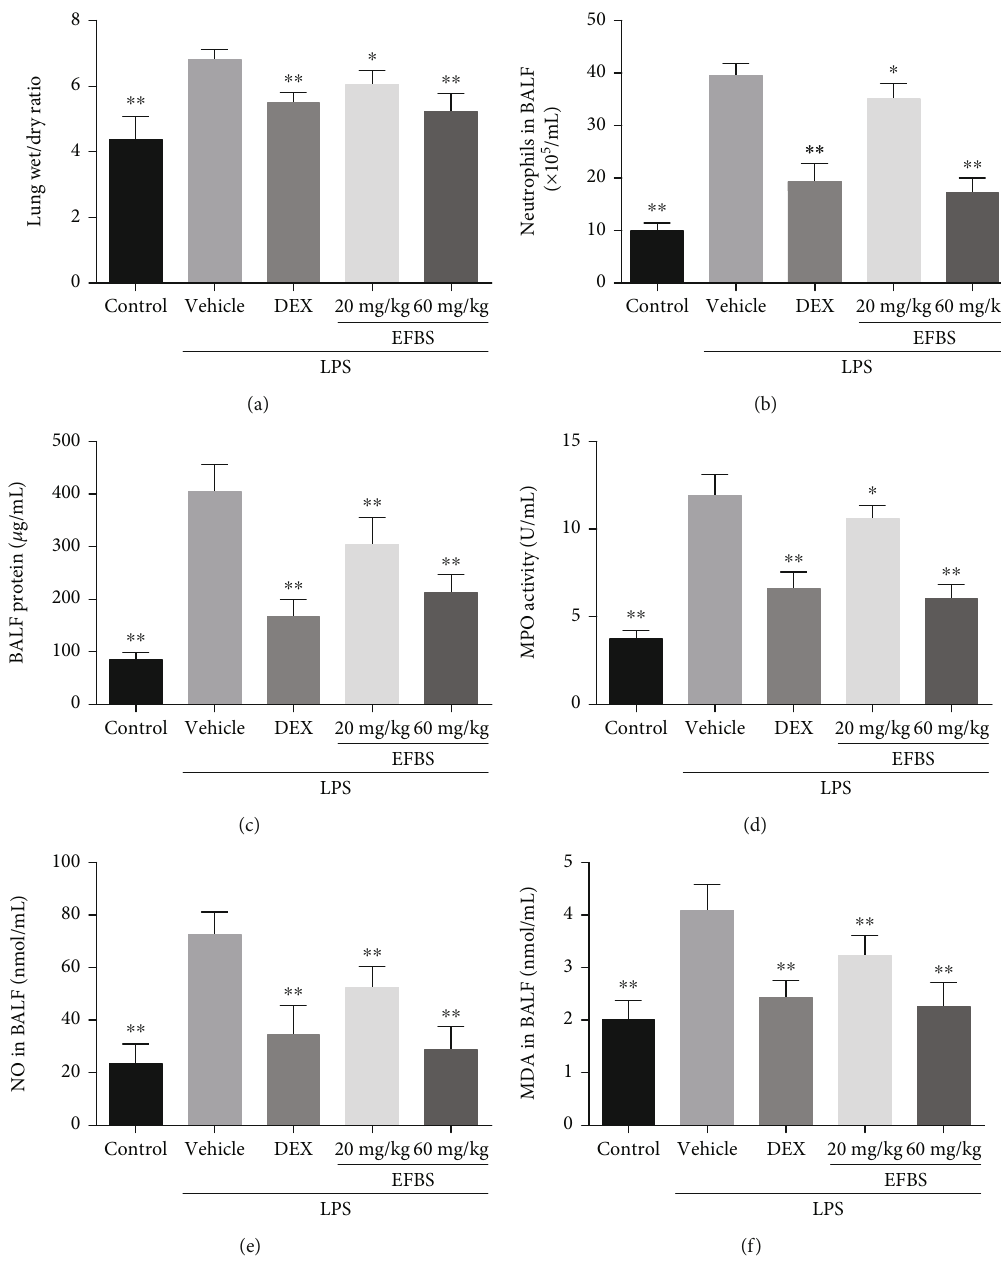
Figure 2: Lung W/D weight ratios for di ff erent groups (a). Protein concentration (b), neutrophil numbers (c), MPO activity (d), NO concentration (e), and MDA concentration (f) in BALF. Data are expressed as mean ± SD ( n = 8 ). ∗ P < 0 : 05 , ∗∗ P < 0 : 01 compared with the vehicle treatment